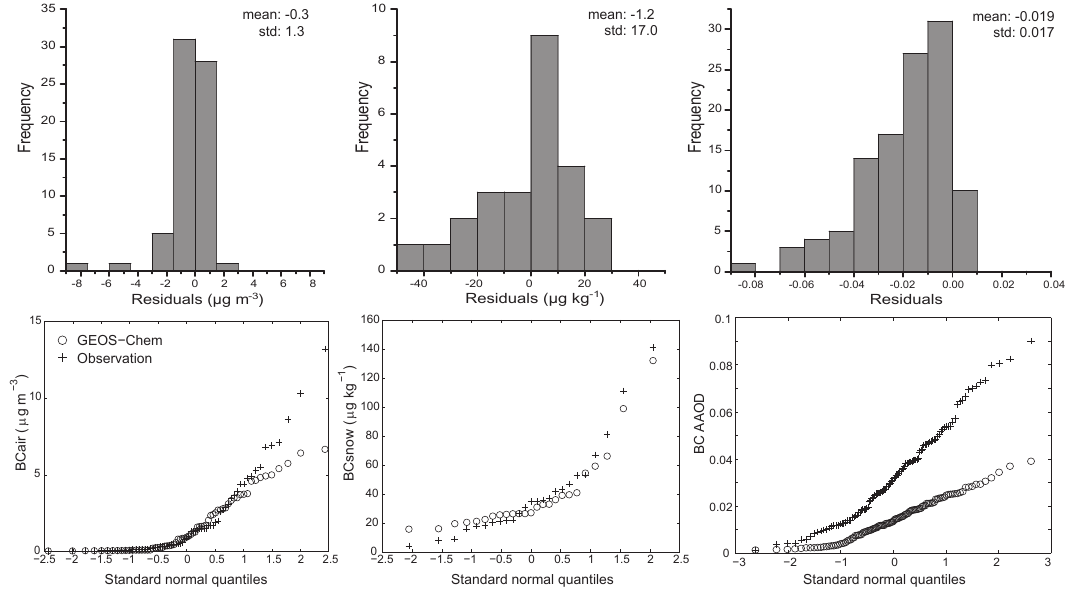
Figure 4. Frequency histogram of residual errors (model–observation) (top row) and cumulative probability distributions (bottom row) for surface BC (left column), BC in snow (middle column), and BC AAOD (right column) at sites in and around the Tibetan Plateau (see Tables 1, 2 and 3 and Fig. 1). Also shown are the mean and standard deviation of residual errors. Values are for 2006 unless stated otherwise. See text for details.